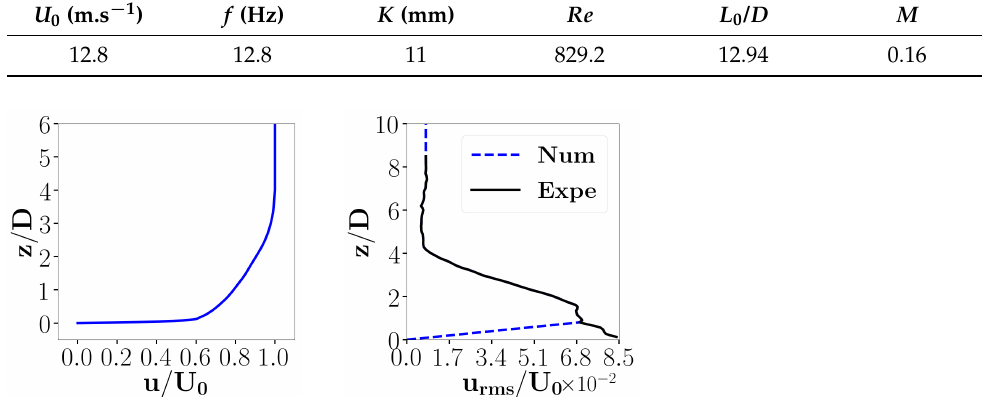
Figure 2. Inlet axial velocity profile ( left ) and inlet axial rms velocity profile ( right ).